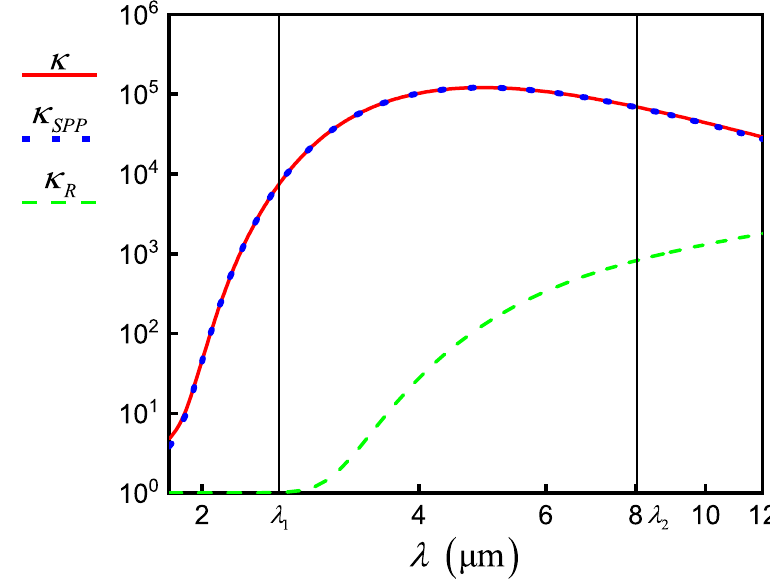
Figure 9. The dependence of relaxation parameters κ (solid red line), κ SPP (dotted blue line), and κ R (dashed green line) as a function of incident field